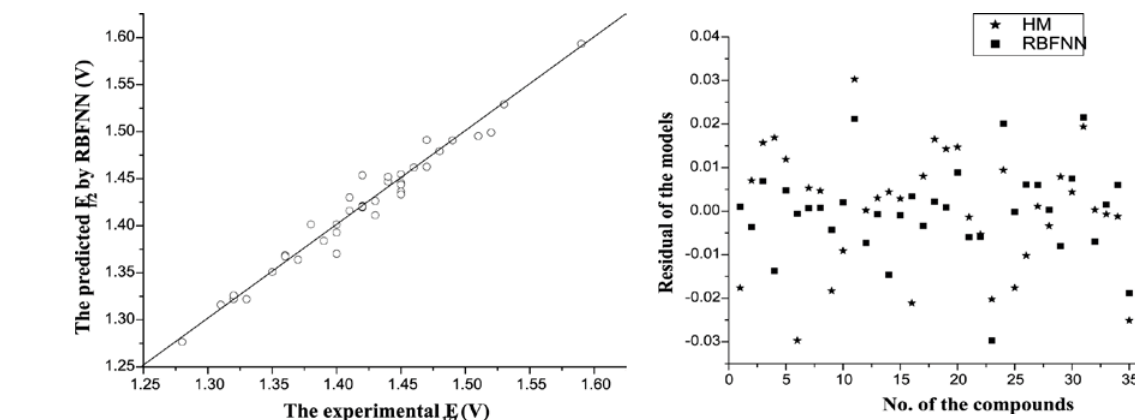
versus predicted E by RBFNN Figure 5. Plot of residual vs. No. of the compounds by HM and 1/2 1/2